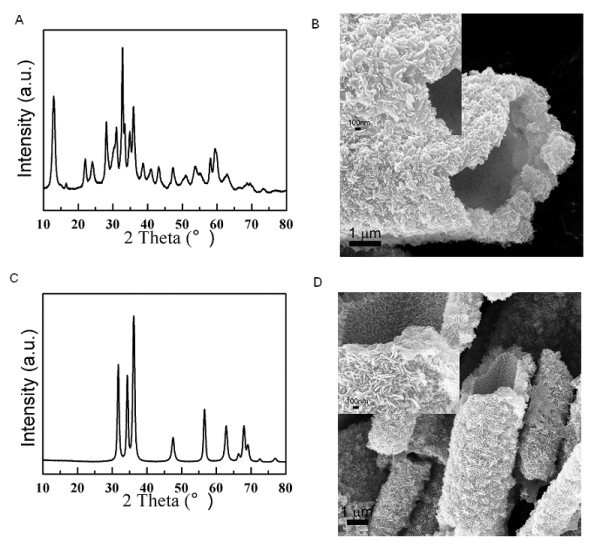
X-ray diffraction pattern and FESEM images. (A) The X-ray diffraction pattern and (B) FESEM image of the white precipitate after the precipitation reaction between ZnSO4·7H2O and (NH4)2CO3 with a molar ratio at 1.0:3.6. (C) The X-ray diffraction pattern and (D) FESEM image of ZnO micro-tubes after the heat treatment of the precipitate in (A).